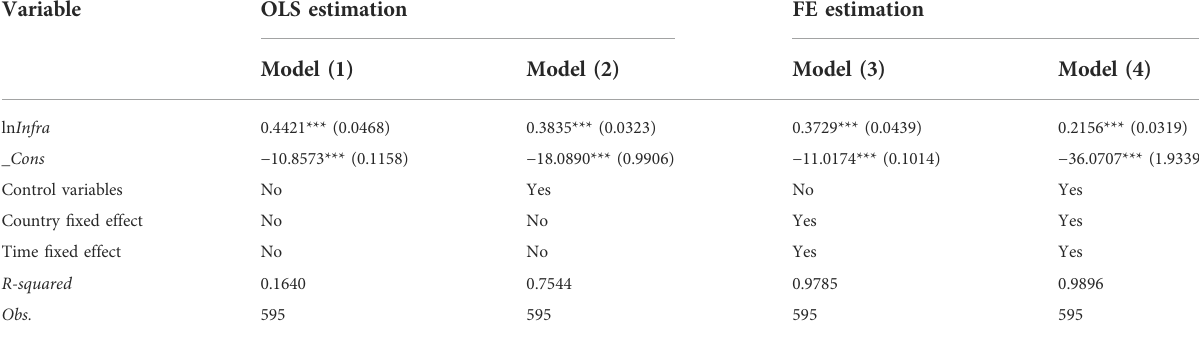
TABLE 4 Robust results of alternative explained